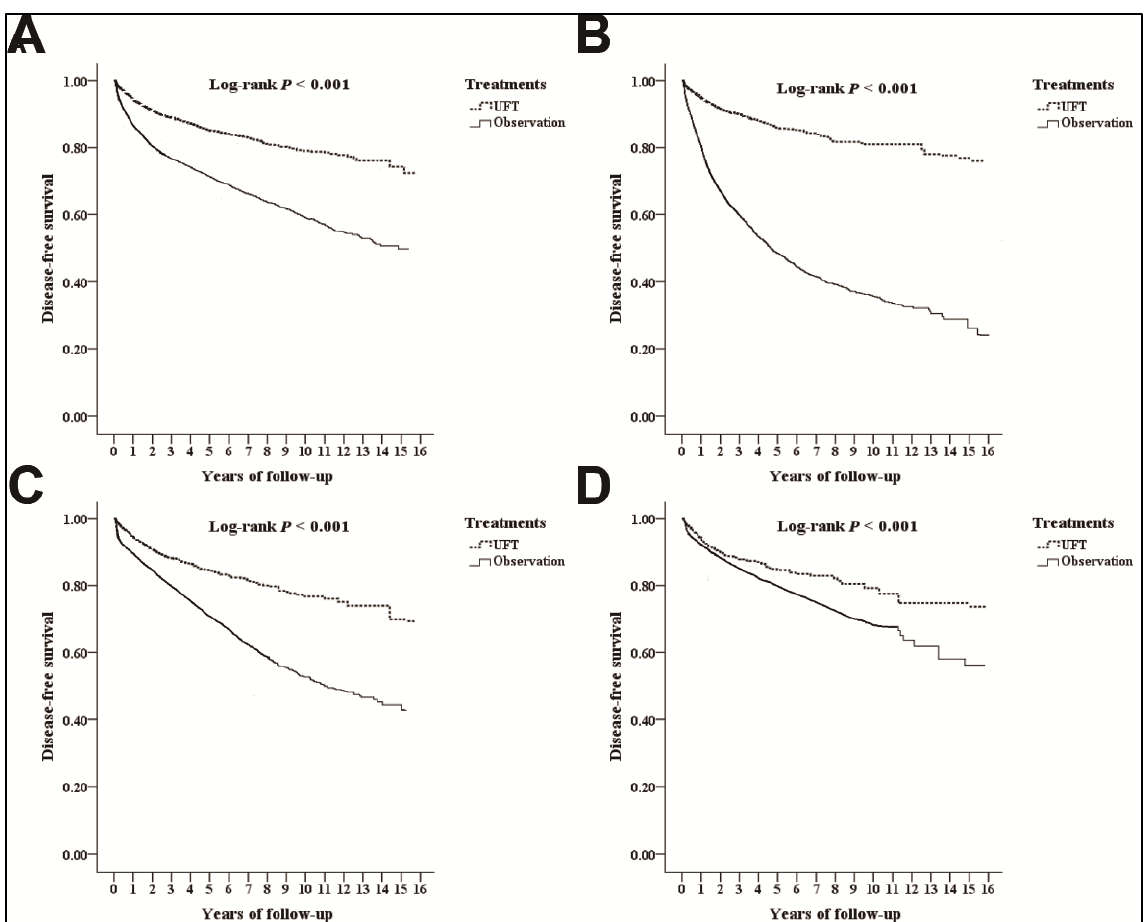
Figure 2. Kaplan – Meier plots for cumulative risk in disease-free survival: overall populations ( A ); Stage IIA ( B ); Stage IIB ( C ); Stage IIC ( D